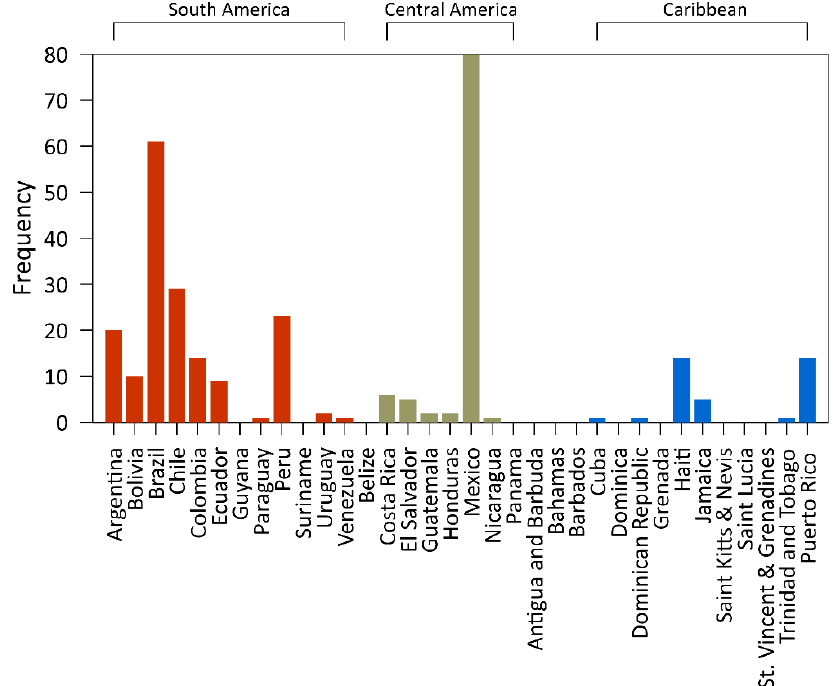
Figure A1. Bar chart of the frequency count of flood-related articles published in WoS-registered journals by LAC country and region.